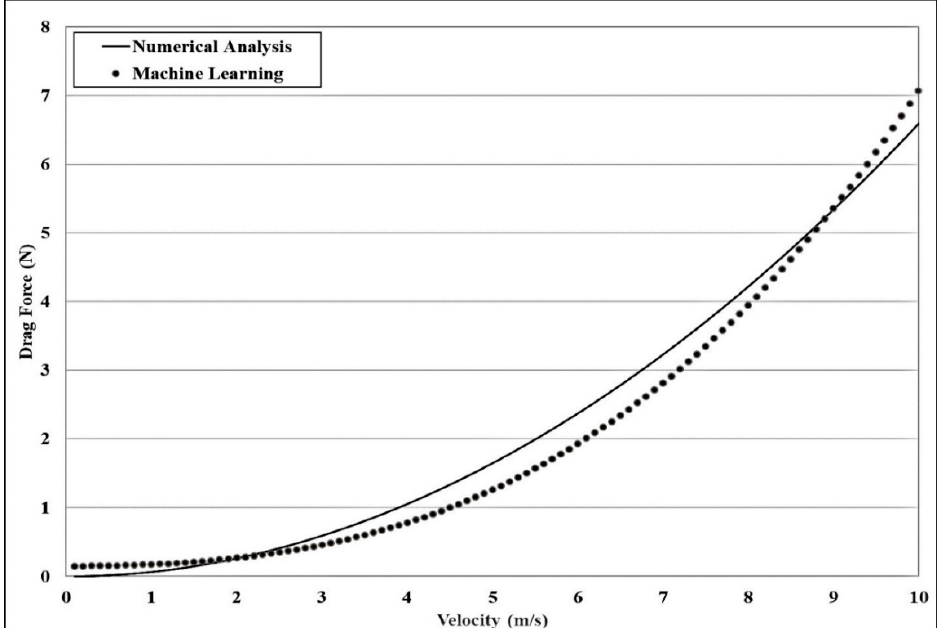
Figure 13. The effect of increasing the wind flow velocity on drag force. Table 4. The accuracy of the LSTM